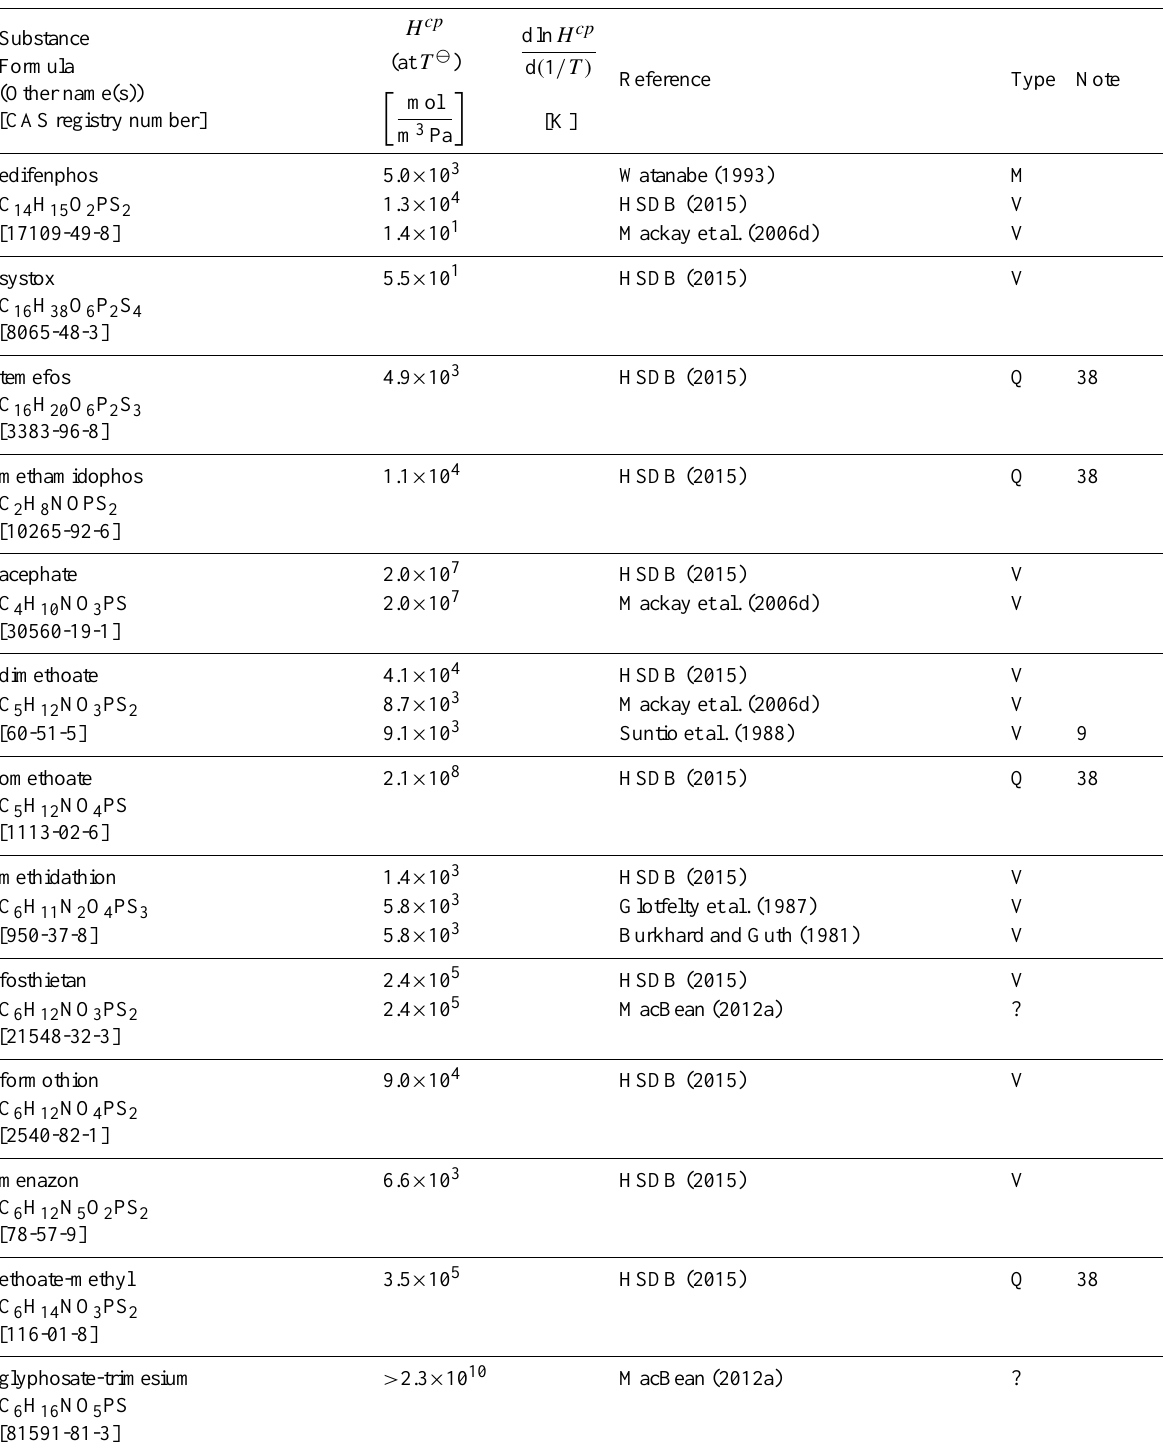
Table 6: Henry’s law constants for water as solvent